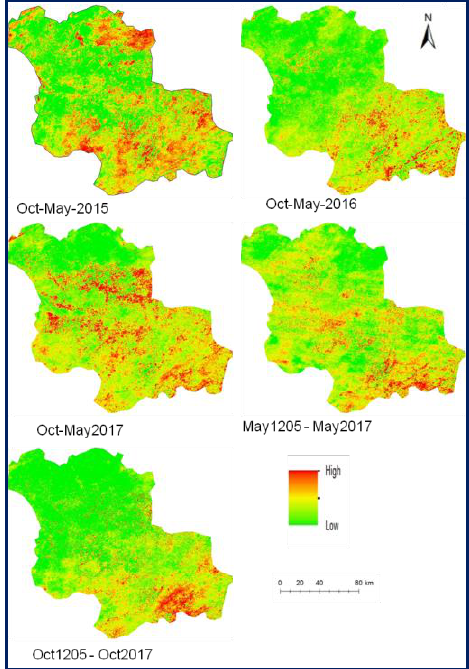
Fig.7. Reclassification of data showing sequential changes in NDVI over the years (2015-2017) Table -1. Area statistics of different categories of NDVI values over the years in Jodhpur District